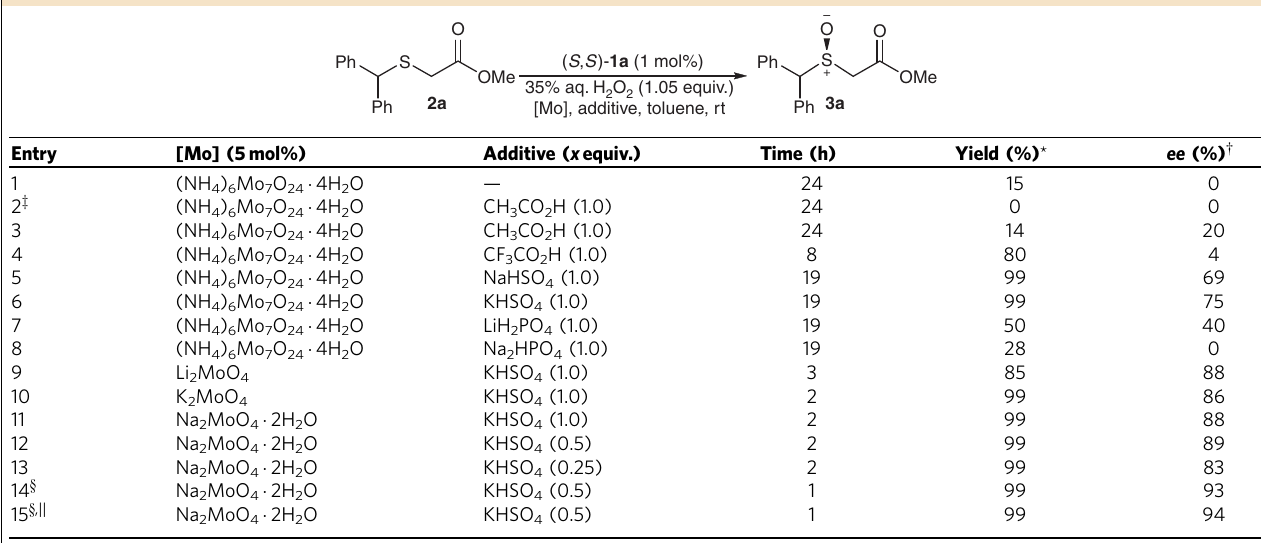
Table 1 | Optimization of bisguanidinium-catalyzed asymmetric sulfoxidation of 2a.